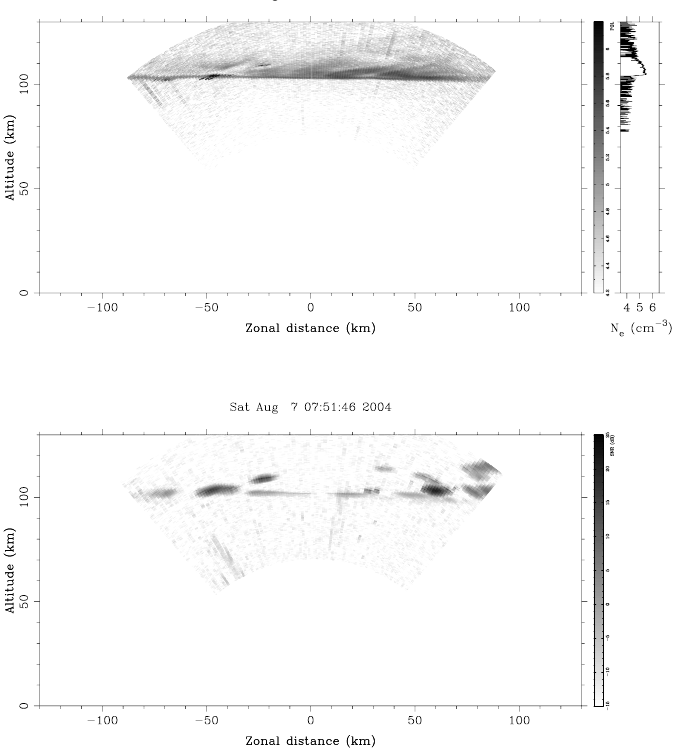
Fig. 4. Altair radar scans of the sporadic E layer in the plane perpendicular to B . The upper and lower panels show UHF data taken with an 88 baud binary phase coded pulse and VHF data taken with a 13 bit Barker code, respectively. The baud length was 1 µ s for both